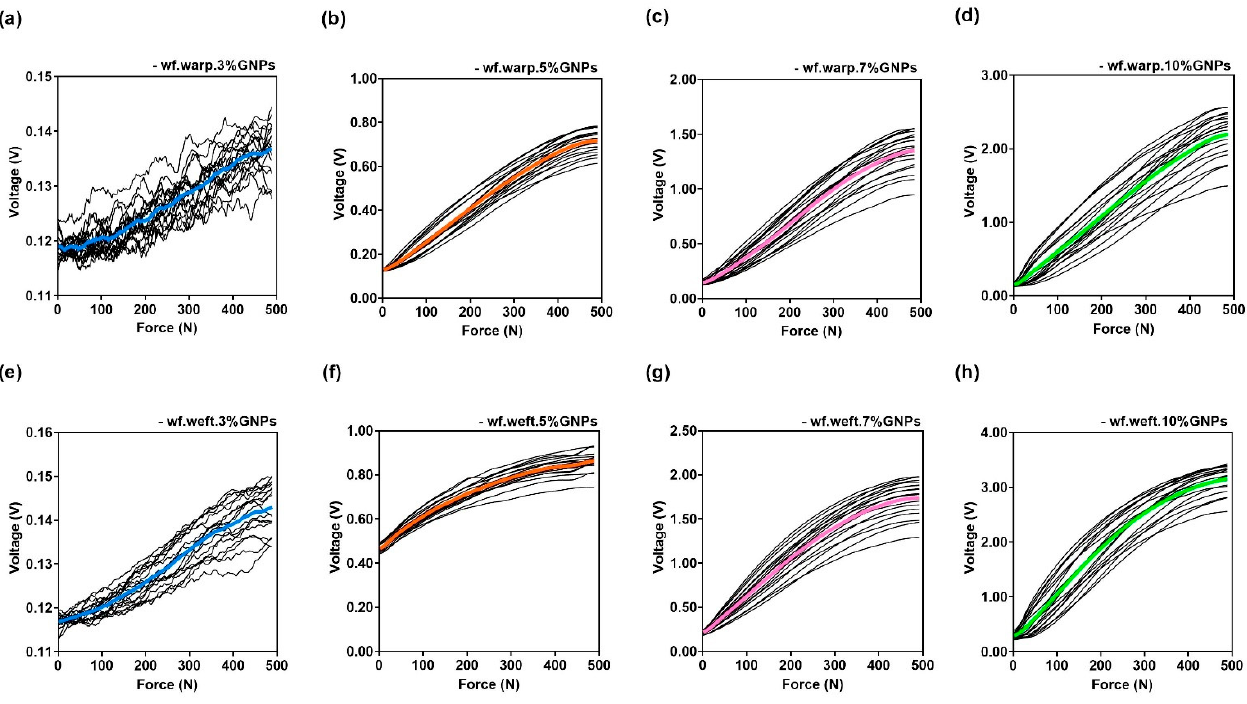
Figure 16. In black, Voltage signal acquired according to the sensor’s resistance, under 10 mechanical compression cycles for ( a ) woven fabric sensor doped with 3% GNPs and assembled in the warpwise direction; ( b ) woven fabric sensor doped with 5% GNPs and assembled in the warpwise direction, ( c ) woven fabric sensor doped with 7% GNPs and assembled in the warpwise direction; ( d ) woven fabric sensor doped with 10% GNPs and assembled in the warpwise direction; ( e ) woven fabric sensor doped with 3% GNPs and assembled the weftwise direction; ( f ) woven fabric sensor doped with 5% GNPs and assembled in the weftwise direction; ( g ) woven fabric sensor doped with 7% GNPs and assembled in the weftwise direction; ( h ) woven fabric sensor doped with 5% GNPs and assembled in the weftwise direction. The coloured curves represent the average values of voltage: 3% GNPs are represented by the colour blue, 5% GNPs are represented by the colour orange, 7% GNPs are represented by the colour pink, 10% GNPs are represented by the colour green.